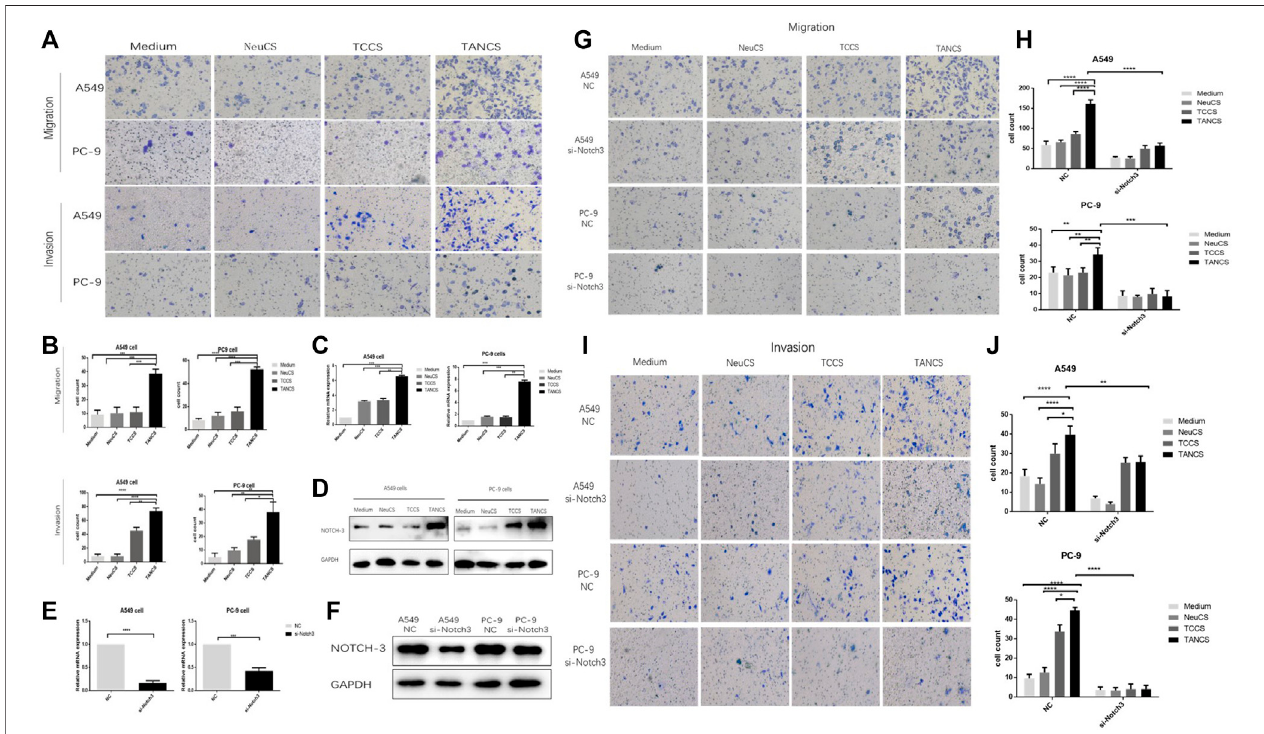
FIGURE3| TANs promoted the migration and invasion of lung adenocarcinoma cells via Notch3. (A,B) A549 and PC-9 cells were stimulated with Medium, NeuCS, TCCS, and TANCS, respectively, then the migration and invasion of cells were observed. The expression of Notch3 in A549 and PC-9 cells stimulated with Medium, NeuCS, TCCS, and TANCS, respectively was detected by PCR assay (C) and Western blot assay (D) . The knockdown effect ofspeci fi csiRNA (si- Notch3) in A549 and PC-9 cells was veri fi ed at both the mRNA (E) , by qRT-PCR) and protein levels (F) , by western blot). (G – J) A549-NC, A549-si-Notch3, PC9-NC, and PC9-si-Notch3 cells were stimulated by Medium, NeuCS, TCCS, TANCS, respectively, then the migration (G – H) and invasion (I-J) of the cells were